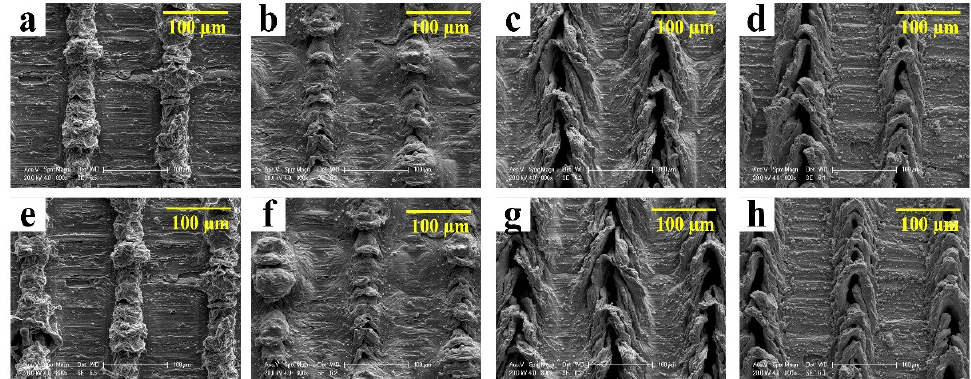
Figure 4. SEM micrographs of laser-structured BMG surfaces at different scanning speeds before and after heat treatment: ( a ) 20 mm/s before heat treatment; ( b ) 40 mm/s before heat treatment; ( c ) 60 mm/s before heat treatment; ( d ) 80 mm/s before heat treatment; ( e ) 20 mm/s after heat treatment; ( f ) 40 mm/s after heat treatment; ( g ) 60 mm/s after heat treatment; ( h ) 80 mm/s after heat treatment.